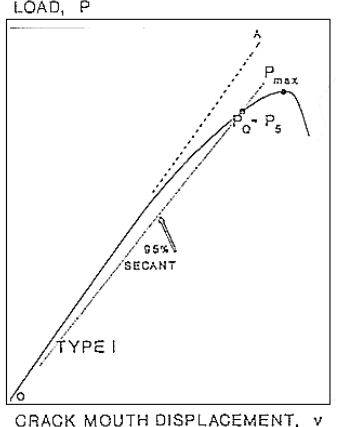
Figure 2. Type-I load-displacement curves for the determination of the critical load P Q then the calculation of the stress intensity factor K Q